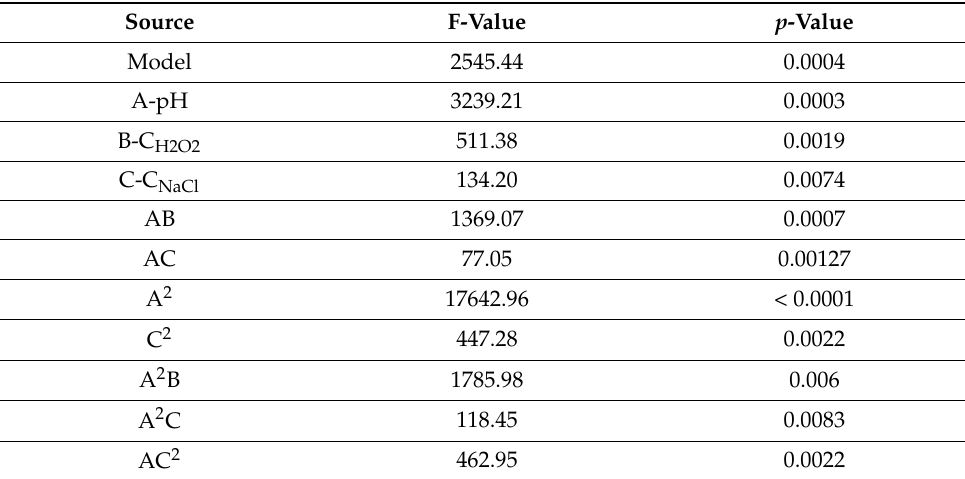
Table 5. ANOVA Table and goodness-of-fit coefficients for response variables.